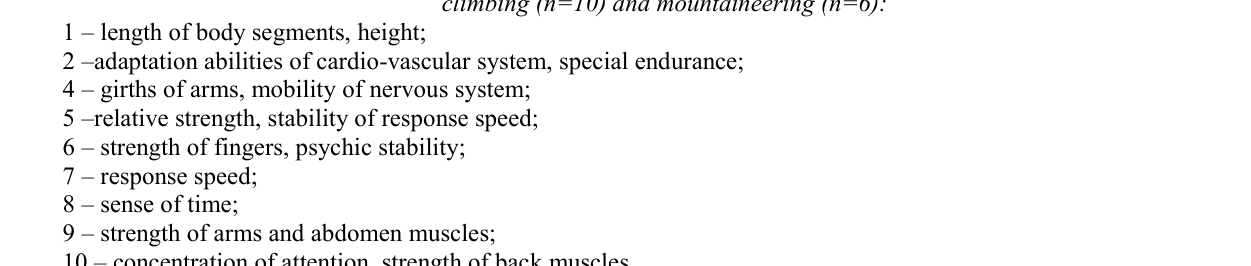
Fig.1. Factorial structure of complex preparedness of elite sportsmen, specializing in speed climbing (n=10), complex climbing (n=10) and mountaineering